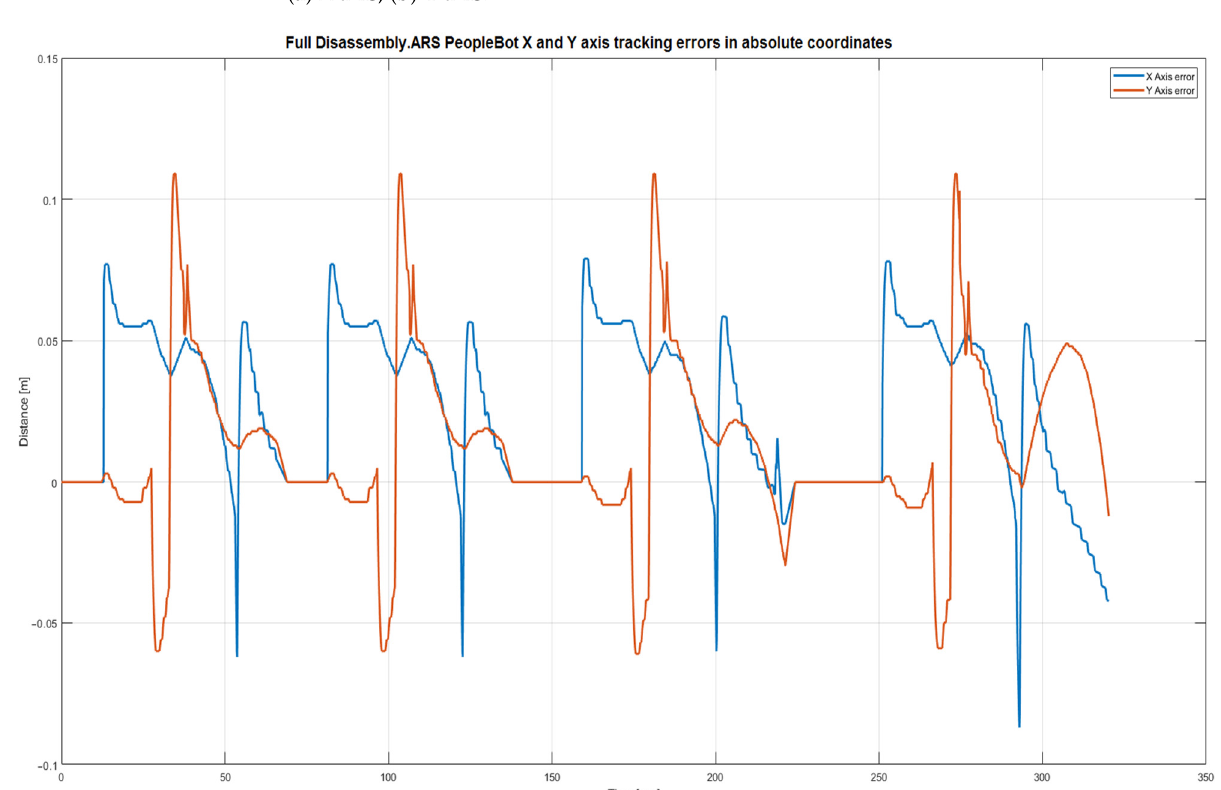
Figure 31. Full disassembly process. Trajectory tracking errors in absolute coordinates.